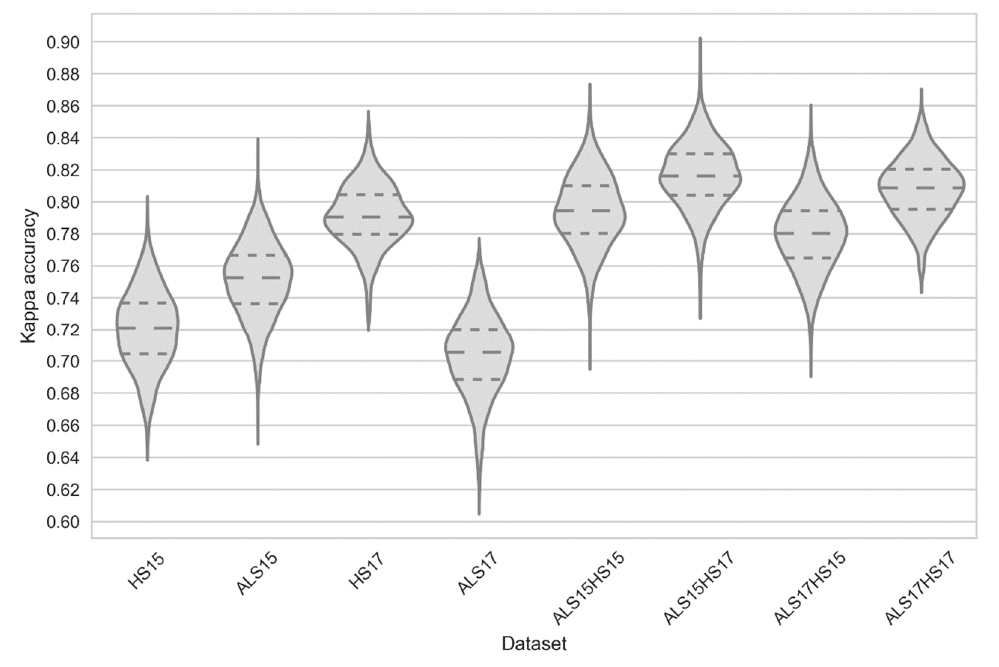
Figure 2. Violin plots illustrating averages, quartiles, and shape of distributions of Kappa accuracy values for eight classification scenarios using di ff erent raster sets of input data. Kappa accuracy values were calculated from the 1000 repetitions of the classification in each scenario, with varying randomized sets of training and validation sampled with 50% / 50% proportion. All scenarios’ results di ff er statistically (one-way ANOVA with Tukey post-hoc test, p < 0.05). Abbreviations: HS—Hyperspectral;